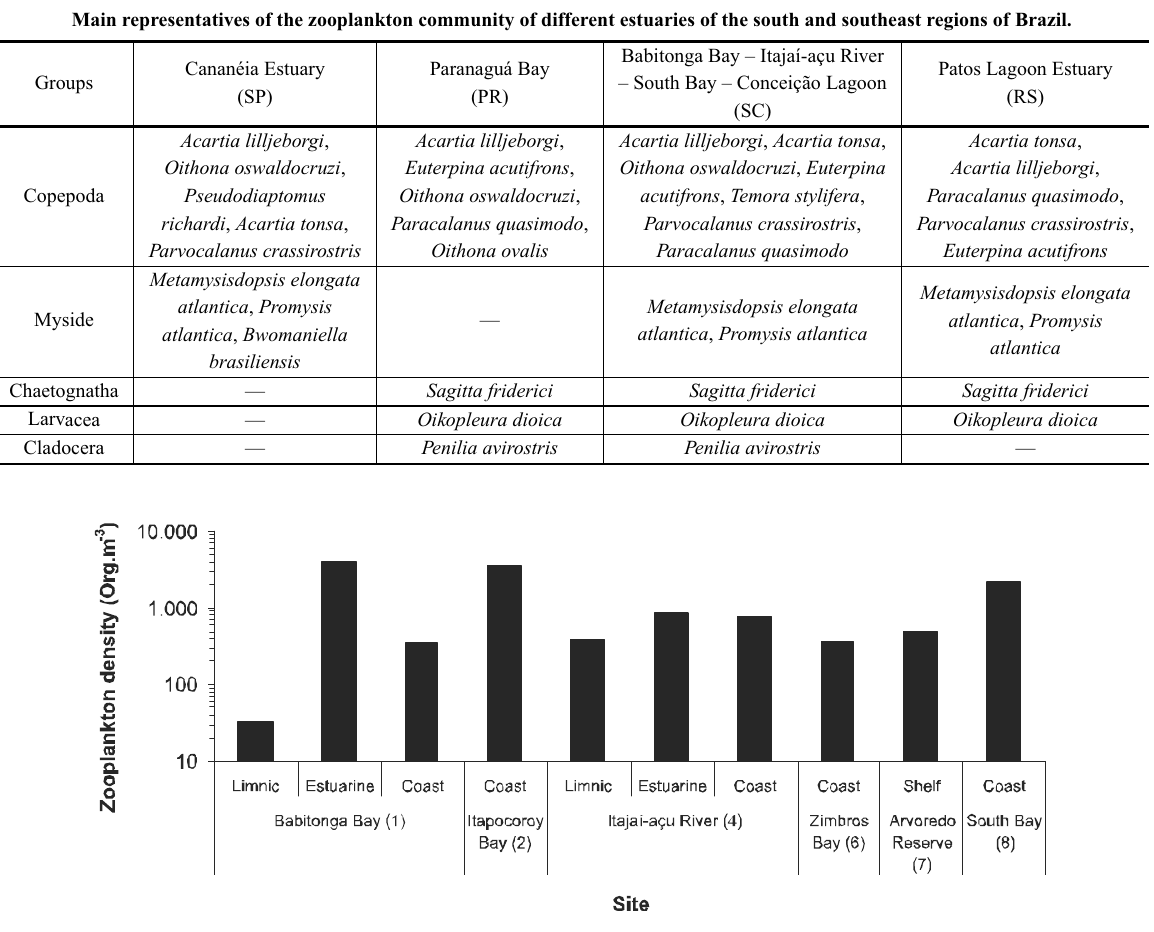
Fig. 3 – Mean of the total values of all data available for the zooplankton densities (Org.m -3 ) in different environments and waters for the Santa Catarina